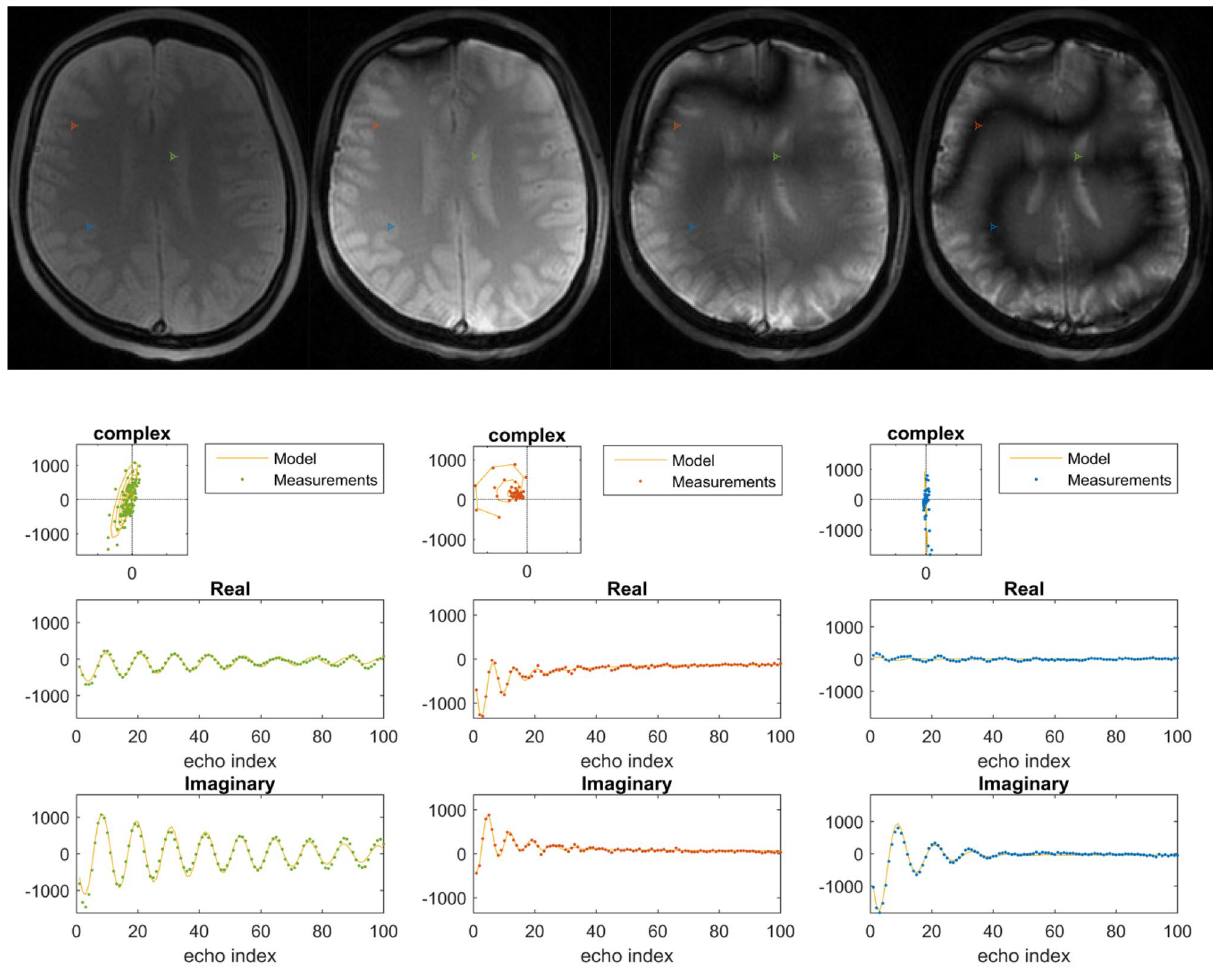
Figure 4. Images in the first row show the transient contrast at time points 1, 3, 5, 7 along the acquisition in a balanced pulse sequence in a “ α x scheme”. The second row shows for this sequence the signal as it evolves along the echo train for three voxels (depicted on the anatomical image). The left and right subfigures shows are from the blue and green voxels, where the spins are on-resonance. The middle subfigure (red voxel) shows a spiral in the complex signal plane. This clearly shows the regularity of the evolution. On the right subfigure middle and bottom the orthogonal real and imaginary components are depicted. The frequency of the oscillations is constant, the decay of the amplitudes is exponential. The steady state is not zero. The fitted curves show the fitted harmonic oscillator